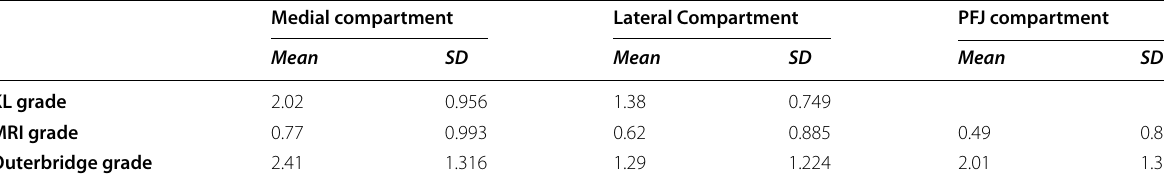
Table 4 Mean grades of arthritis seen in knee compartment by imaging modality Medial compartment